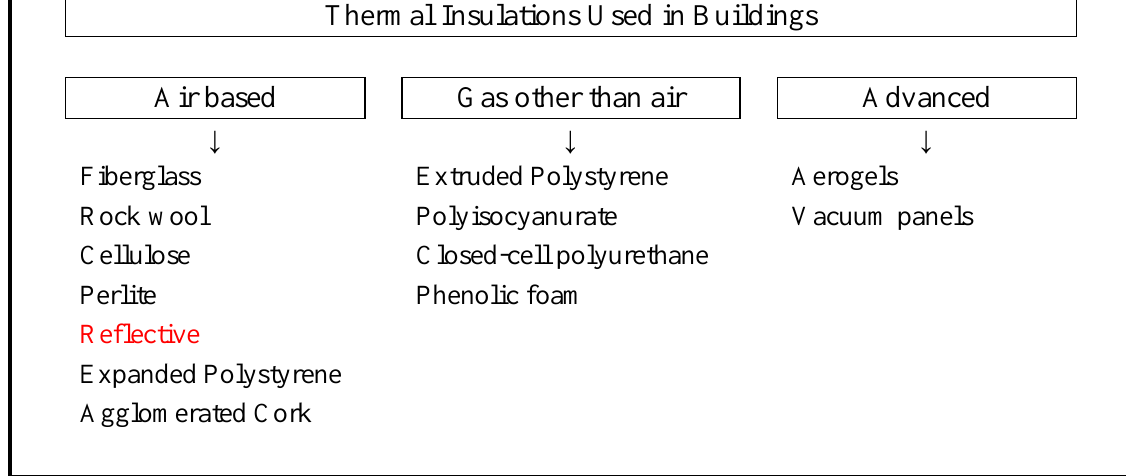
Figure 1: Examples of three categories of thermal insulation materials